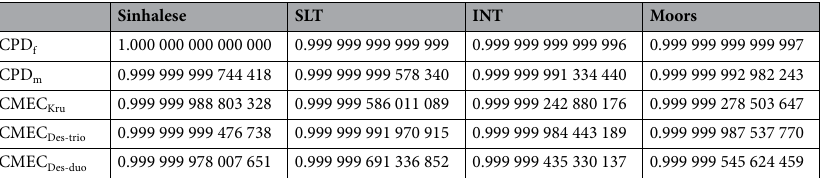
Table 6. Combined forensic efficiency parameters calculated for the 16 X-STR loci in the four ethnic groups based on the haplotypes frequencies of the four clusters and the allele frequencies of the three individual markers. CPD f combined power of discrimination in females, CPD m combined power of discrimination in males, CMECKru combined mean exclusion chance Kruger, CMEC Des-trio combined mean exclusion chance Desmaris trio, CMEC Des-duo combined mean exclusion chance Desmaris duo, SLT Sri Lankan Tamil, INT Indian